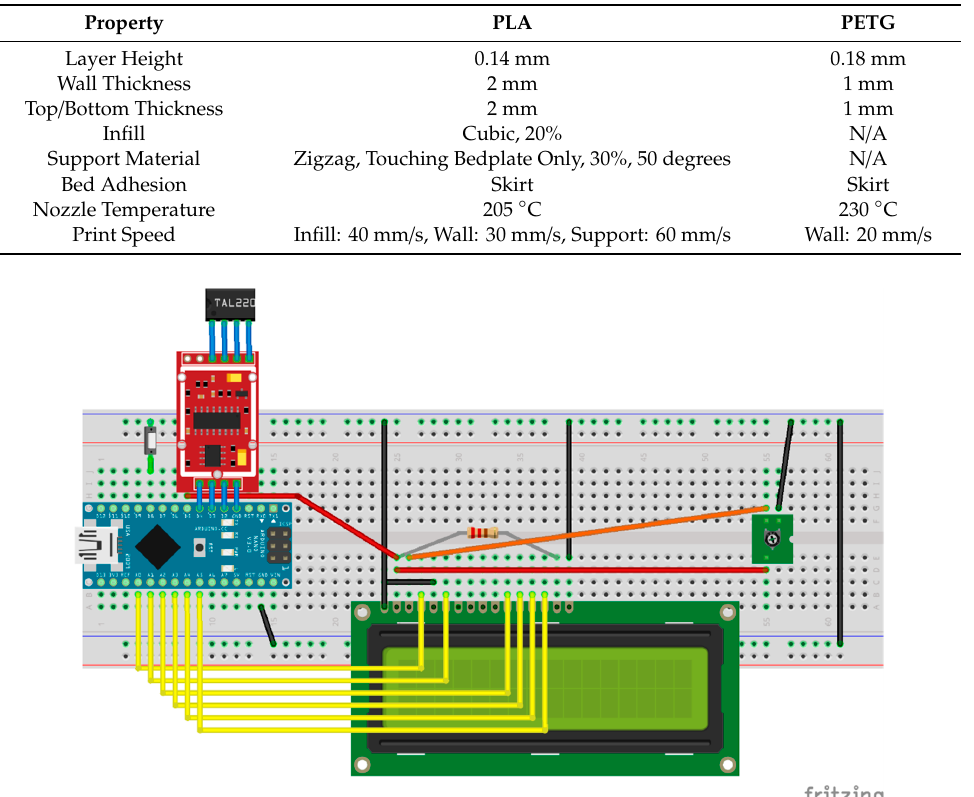
Figure 1. Electrical circuit breadboard layout. Please note that all components connected to and Instruments 2020 , 4 , 18 including the LCD are optional.